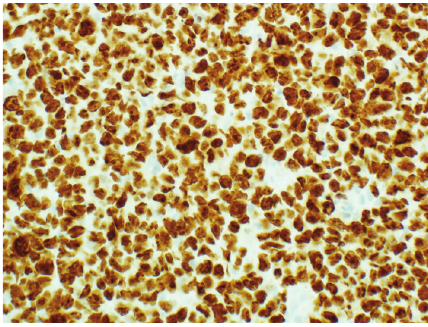
Figure 6: Ki-67 proliferation index of > 99% (MIB-1 immunostain, × 400 magnification).